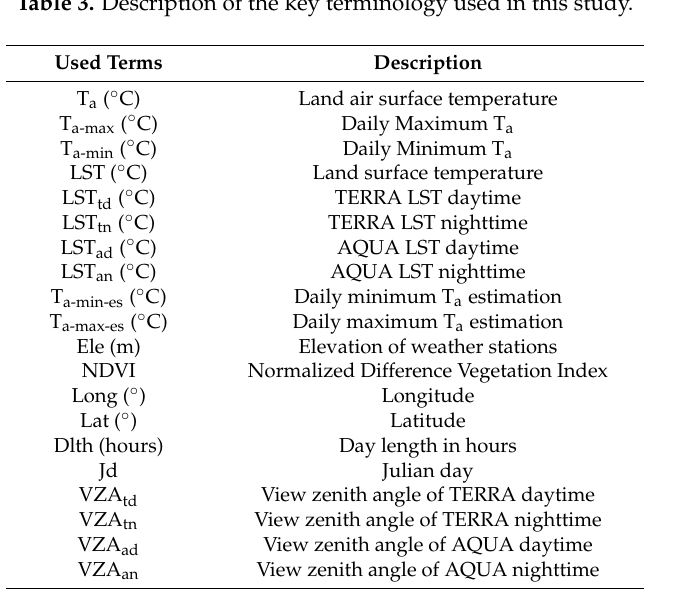
Table 3. Description of the key terminology used in this